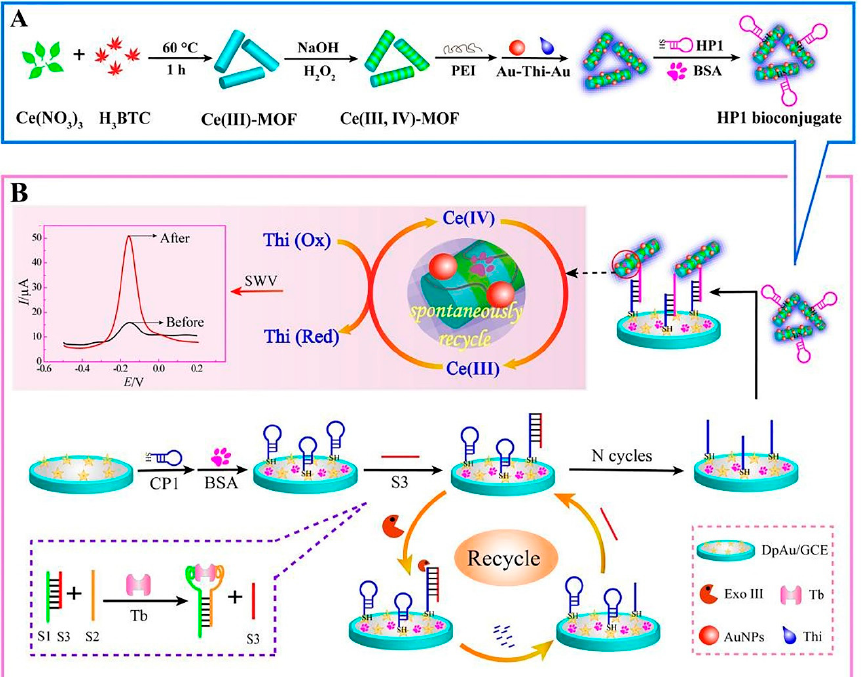
Figure 2. MOF-voltammetric aptasensor for TB determination: ( A ) Construction steps of HP1 bioconjugate (HP1/Au-Thi-Au@Ce (III, IV)-MOF), and ( B ) the manufacturing process of the Ce (III, IV)-MOF electrocatalyst with Exo III-assisted recycling amplification [49].